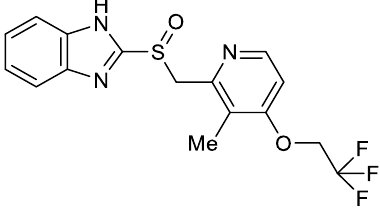
Figure 2. Structure of lansoprazole.